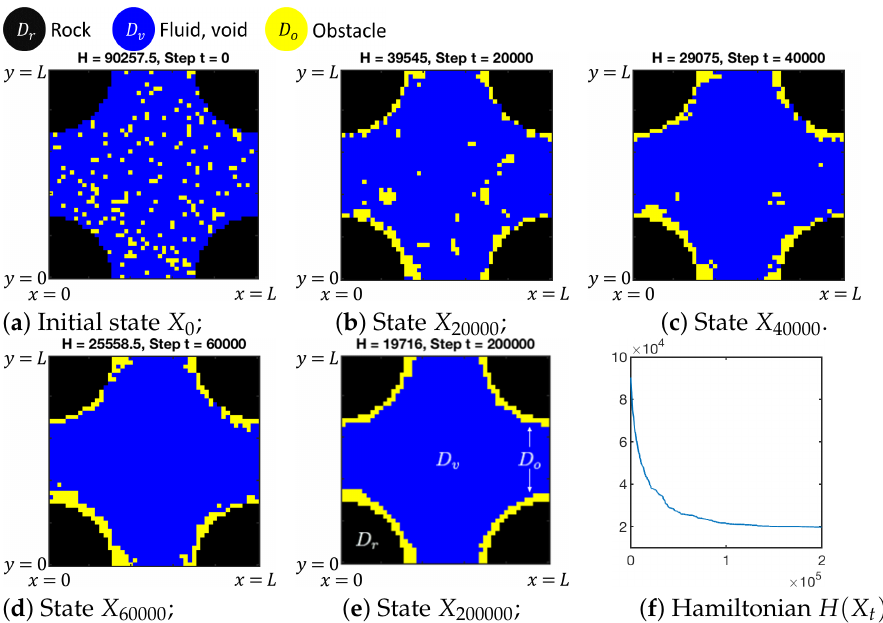
Figure 12. States of the LP model process for the formation of an obstruction from Section 5.2. Rock matrix D r , is black, void space D v is blue and the obstruction D o is yellow. M = 50 ×